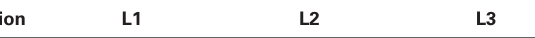
Table 1 | Pearson correlation results between resting alpha amplitude and learning indices